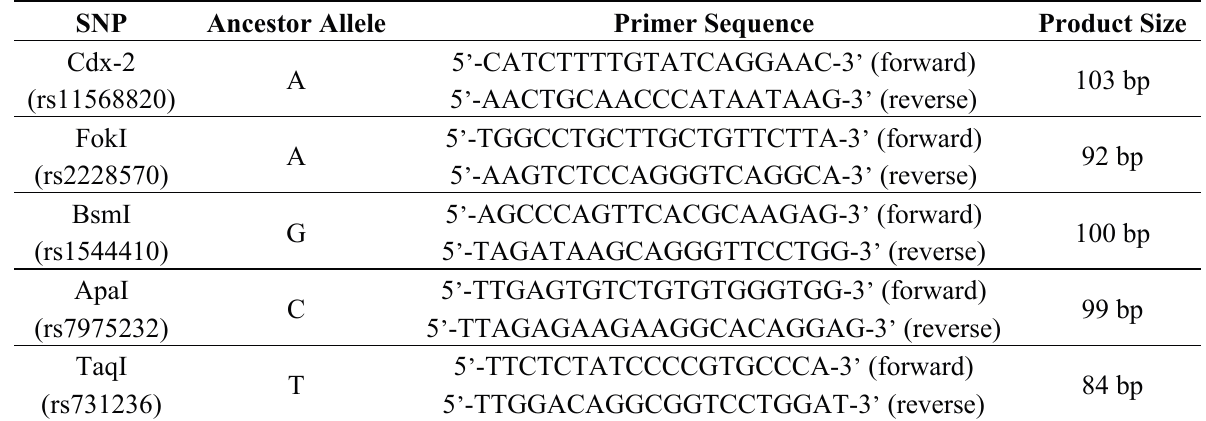
Table 1. Primers of target genes used in the